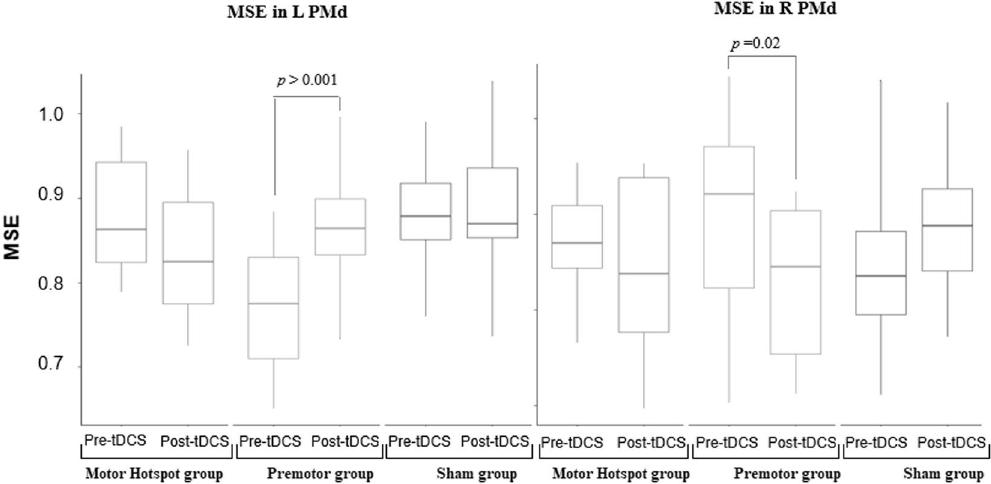
Figure 3. Changes in MSE across groups. Box-and-whisker plots of the MSE per group over time (pre/post- tDCS) in the left PMd ROI (in the left panel) and in the right PMd ROI (in the right panel). The center line represents the median value, the lower bound of the box represents the 25th percentile, the upper bound of the box the 75th percentile, and the whiskers represent 3 times the interquartile range. Any outliers are indicated by dots. The p-values refer to the statistically significant post-hoc contrasts. L: left, M1: primary motor area, MSE: multiscale entropy, PMd: dorsal premotor cortex, R: right, tDCS: transcranial direct current stimulation .